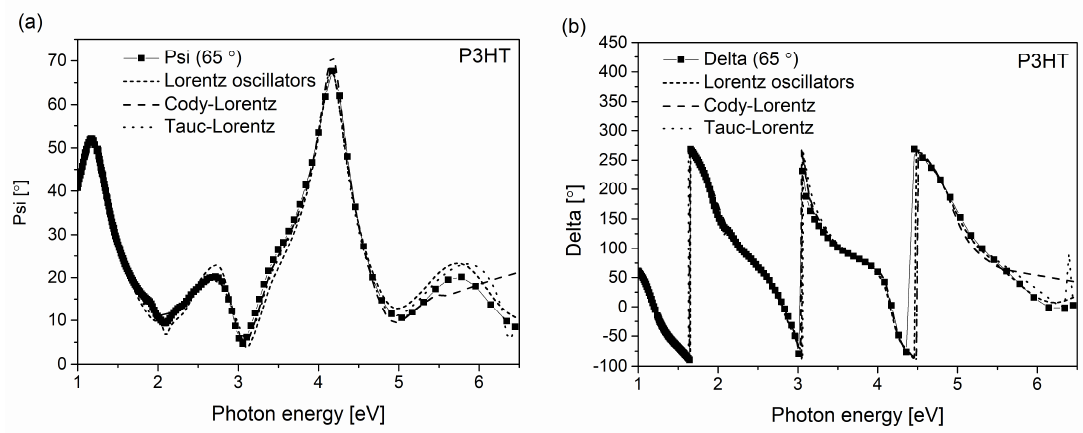
Figure 6. Spectra of P3HT ellipsometric angles ( a ) Psi, ( b ) Delta.